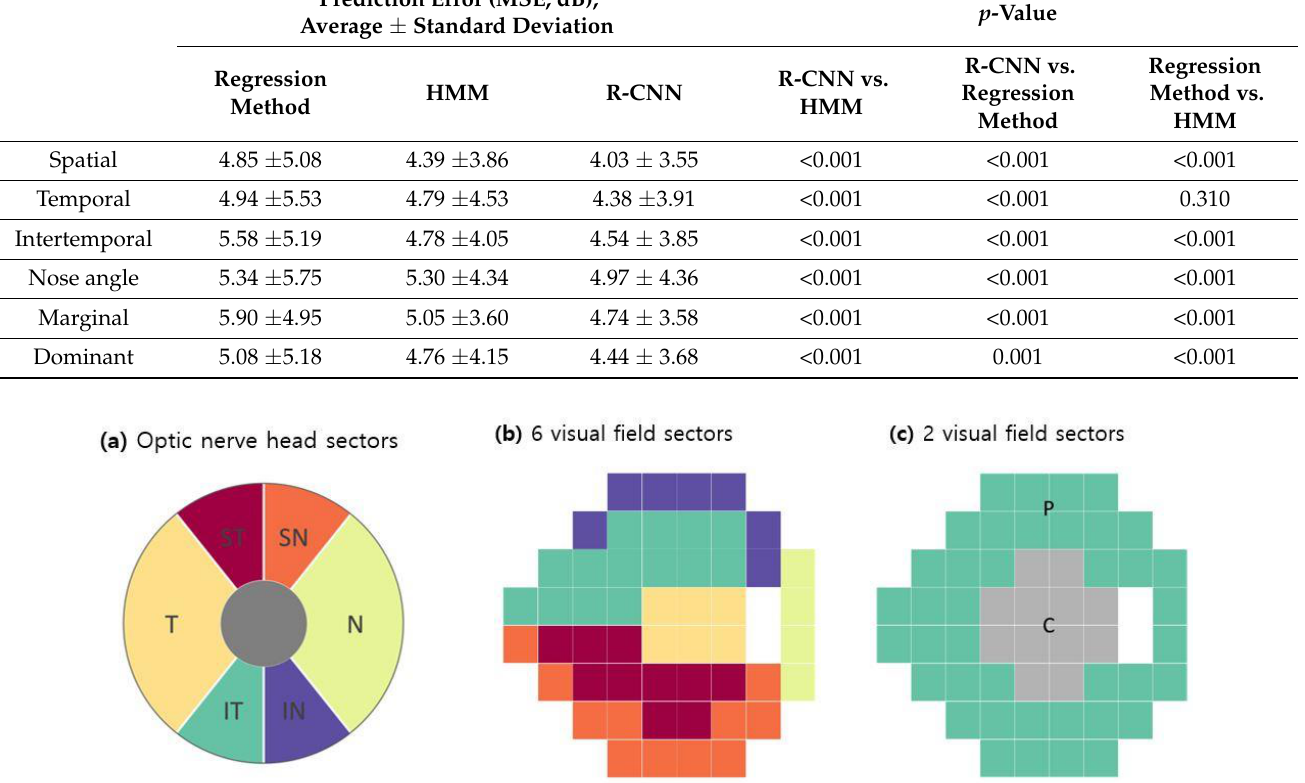
Figure 7. Representation of the optic nerve ( a ) and spatial field ( b , c ). ( b ) The spatial field is partitioned into six parts ( c ) The spatial field is partitioned into central and marginal parts. Table 11. Mean classification error (MSE) according to reliability metrics.